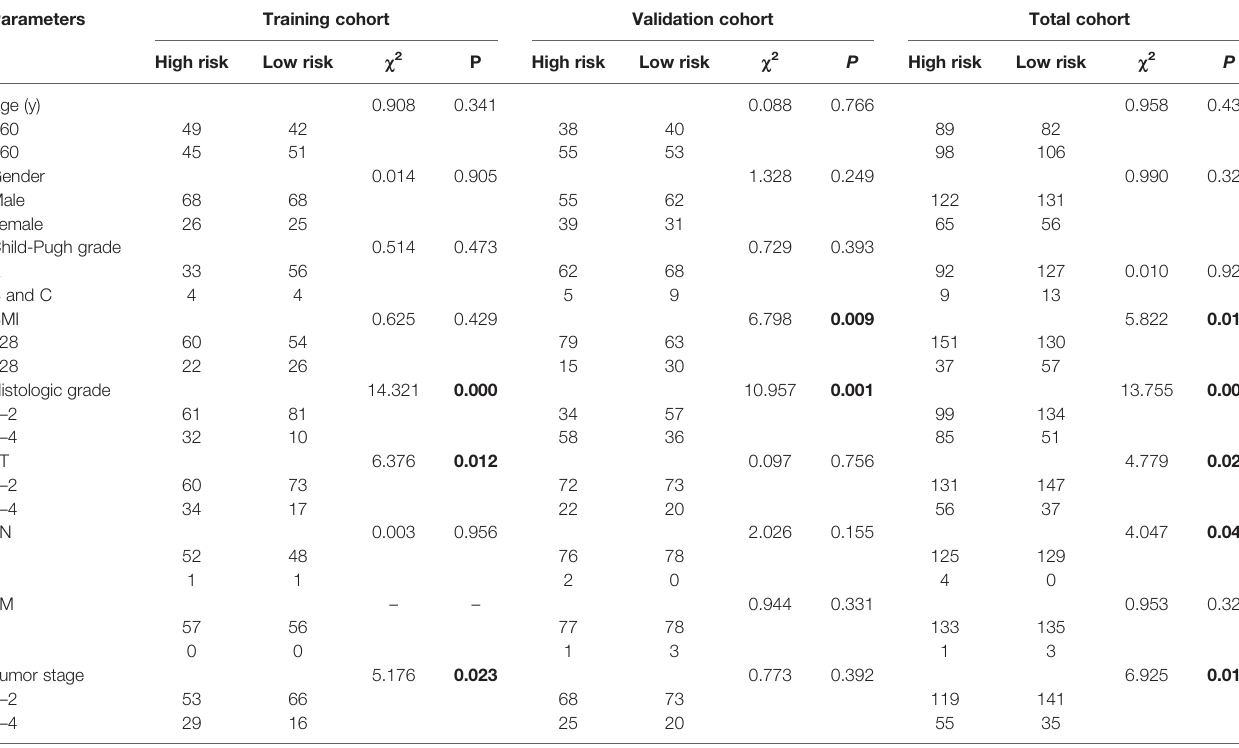
Bold values are statistically signi fi cant.